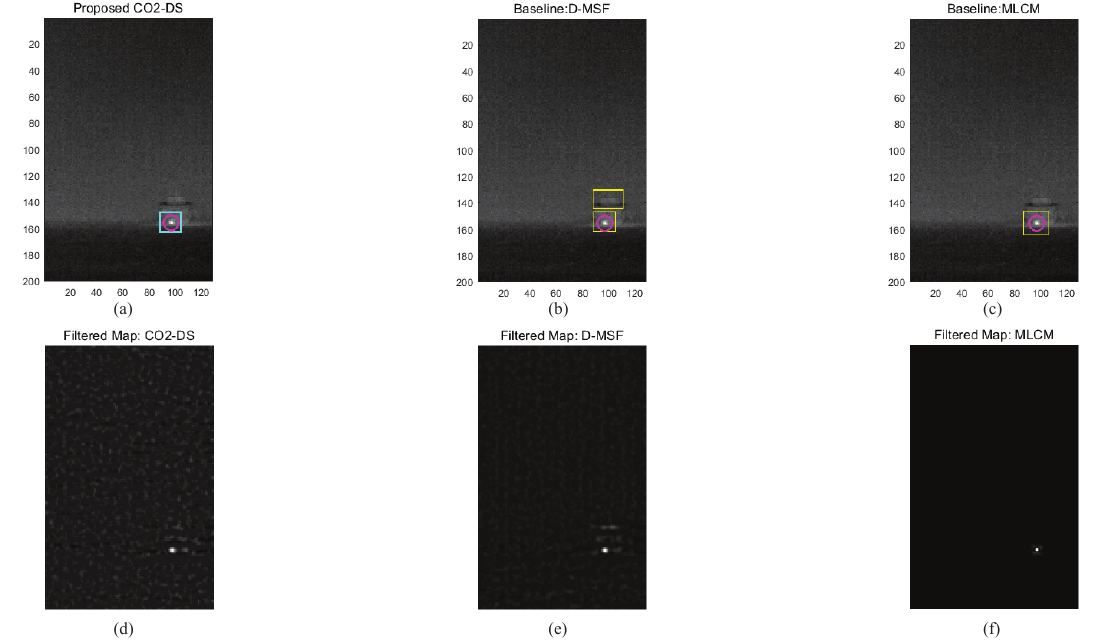
Figure 15. Comparative detection examples for a homogeneous background: ( a – c ) detection results, ( d – f ) filtered